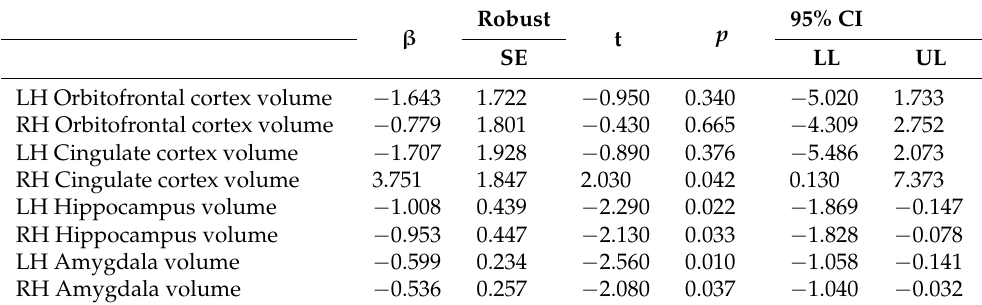
Table 2. Associations between parental internalizing behavior and children’s limbic brain structures volume (mm 3 ) *.